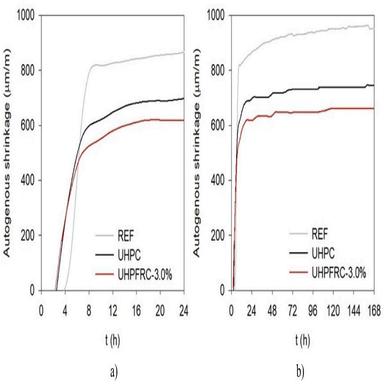
Autogenous shrinkage evolution: a) up to 24 h; up to 168 h).